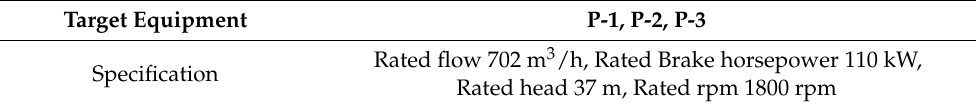
Table 5. Inverter-type pump